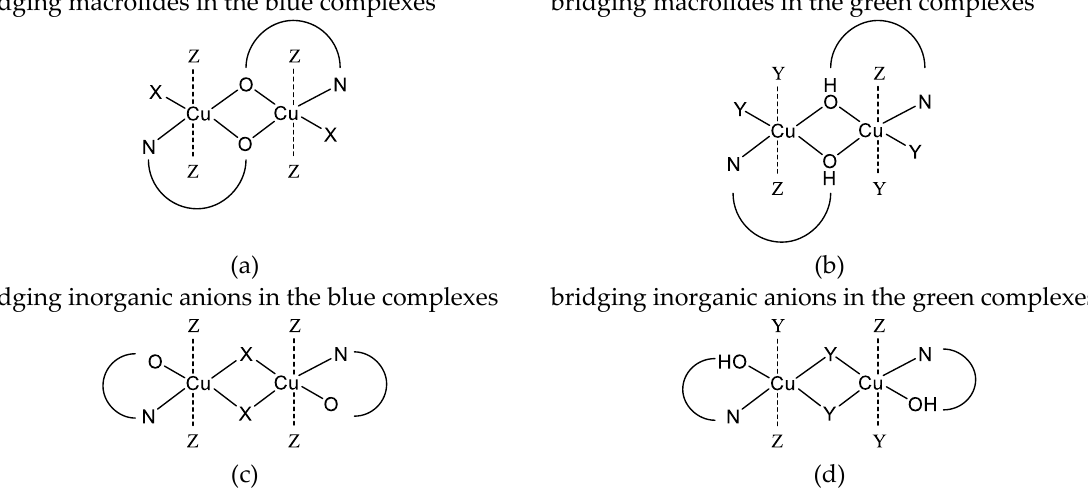
Scheme 2. Suggested coordination modes of macrolides and inorganic anions in the ( a , c ) blue (X = NO 3– ) and ( b , d ) green (Y = Cl – ) complexes (Z—solvent